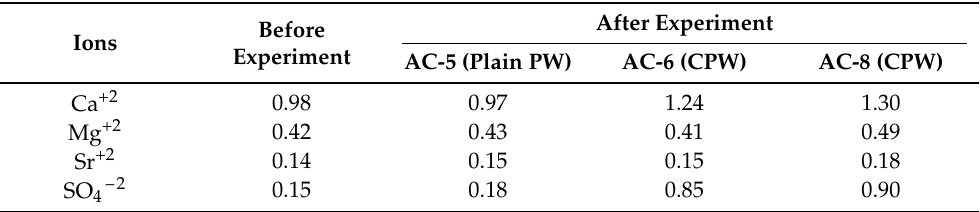
Table 5. Ionic composition measured as g/L of all the fluids used in the spontaneous imbibition experiments for AC5 (plain PW), AC6(CPW), and AC8 (CPW). After Experiment Before Ions Experiment AC-5 (Plain PW) AC-6